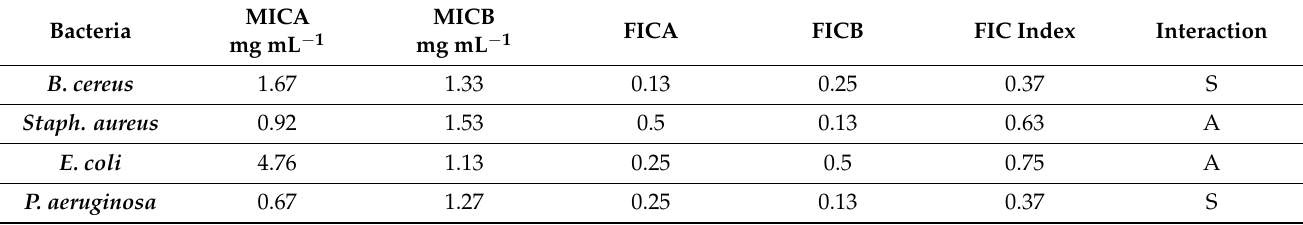
Table 5. Synergic interaction between hesperidin and NaNO 2 against the tested foodborne pathogenic bacteria.